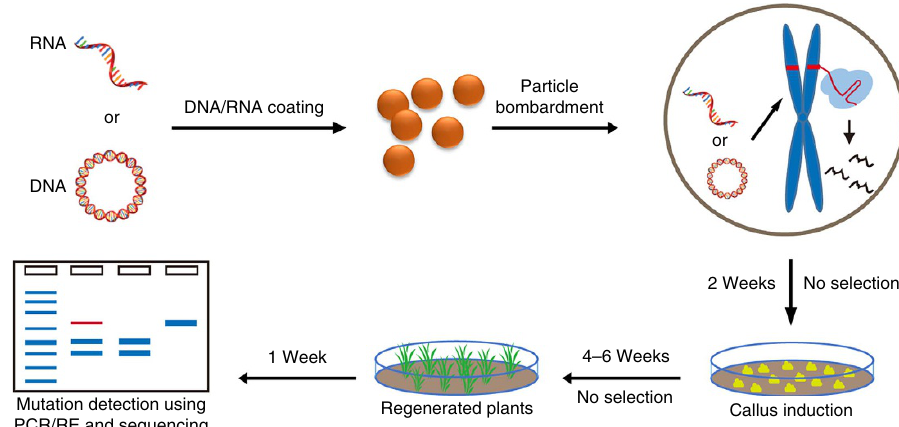
Figure 1 | Overview of the genome-editing methods based on TECCDNA or TECCRNA. The CRISPR/Cas9 DNA (plasmid constructs) or RNA ( in vitro synthesized transcripts) is delivered into immature wheat embryos by particle bombardment. After transient expression and function, CRISPR/Cas9 DNA or RNA becomes degraded, while the bombarded embryos produce callus cells from which seedlings are regenerated. The T0 seedlings are examined using PCR-RE assay and DNA sequencing to identify targeted